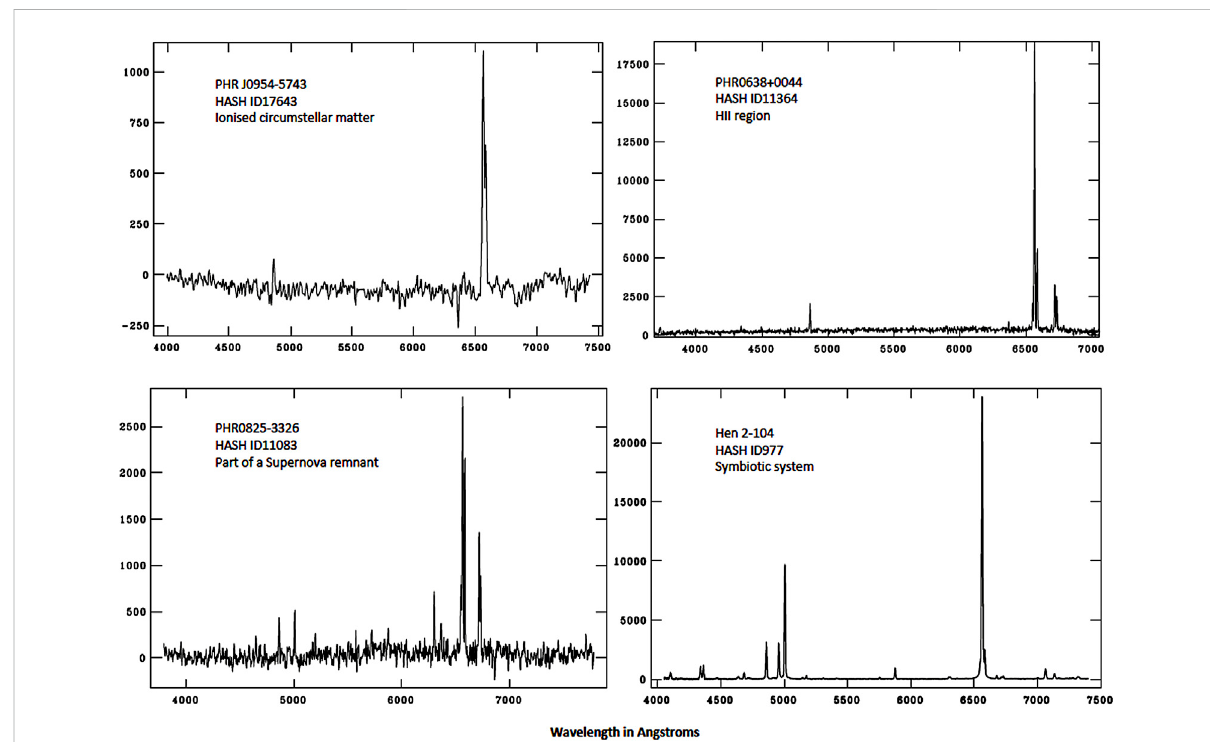
FIGURE 5 Example spectra of four mimics, three of which are the same as the images in Figure 4. Note the different lines, their intensities and ratios c.f. PNe spectra that signi fi cantly aid in object identi fi cation. The vertical axis is relative intensity.